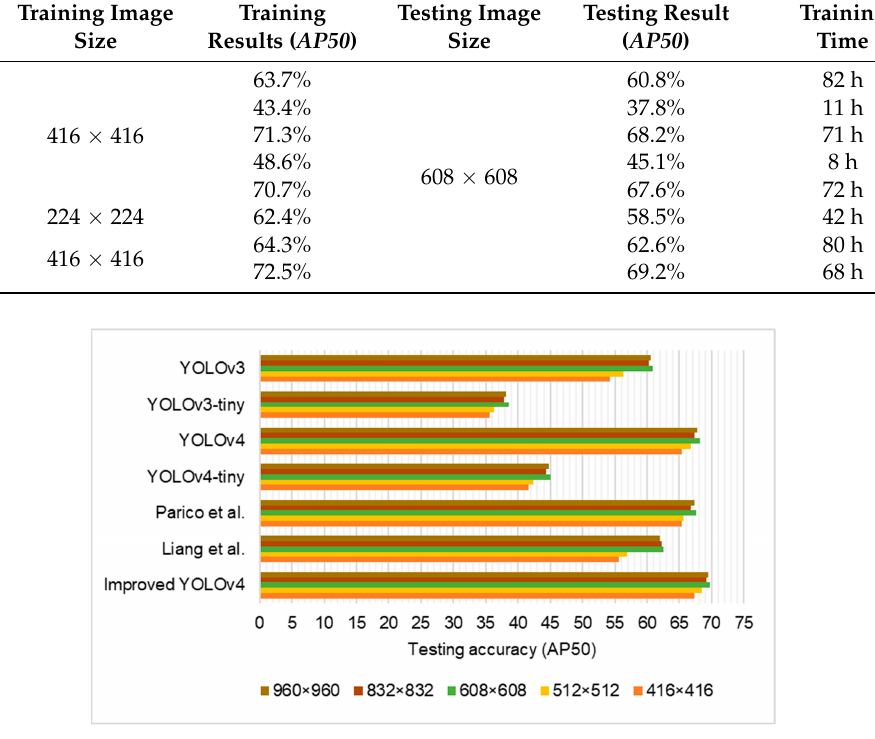
Figure 7. Performance of the models with varied test picture sizes [36,47].